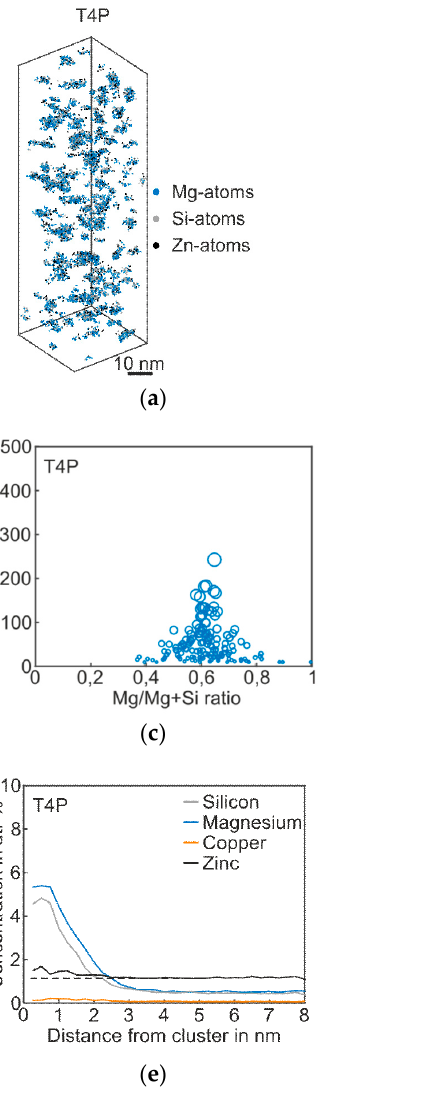
Figure 4 . APT analyses of Alloy Zn visualizing the 3D atom maps of Mg–Si co-clusters ( a , b ) in T4P and T6P conditions. The corresponding cluster size distributions and proxigrams are shown in ( c – f ). The di ff erent circle diameters in ( c ) and ( d ) indicate the cluster size. The dotted lines in ( e , f ) reflect the matrix concentration level of